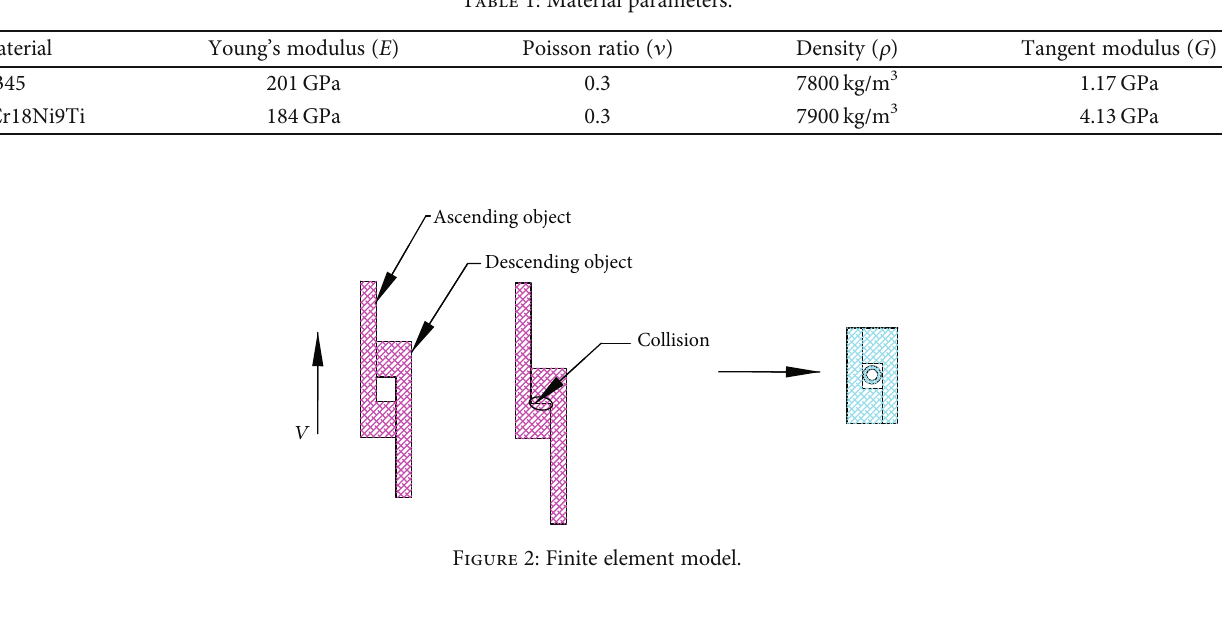
Table 1: Material parameters.